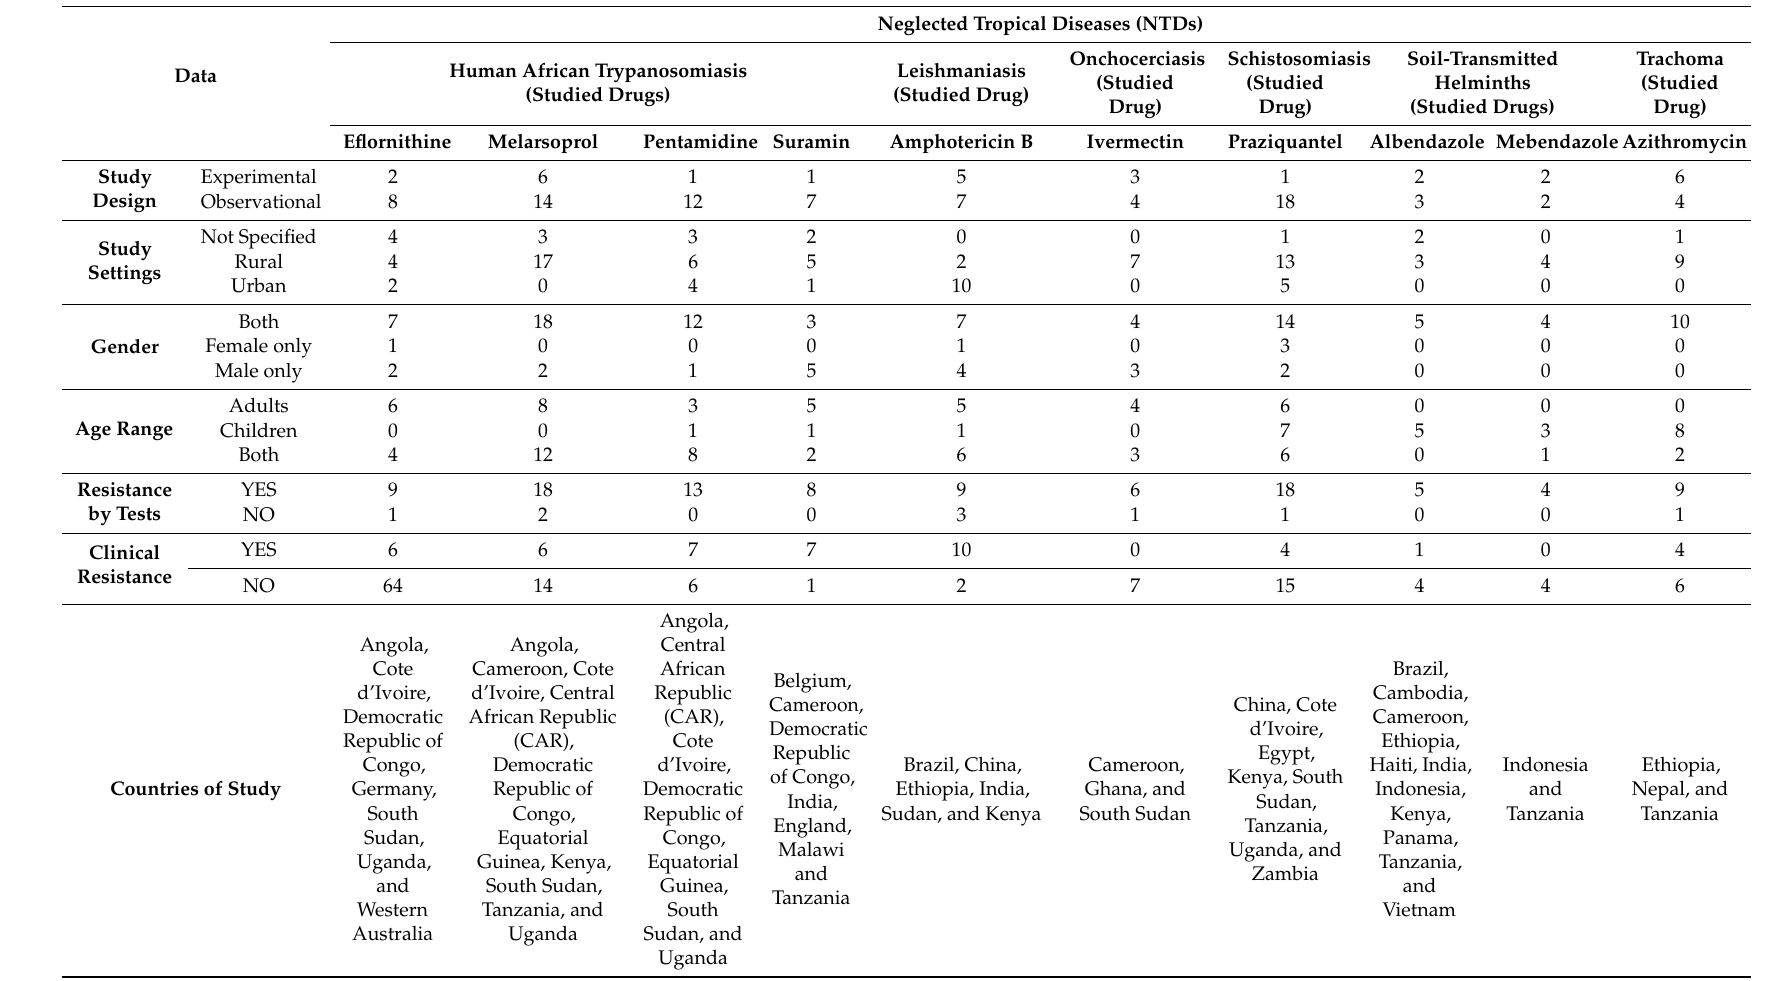
Table 1. The characteristics of reviewed NTDs and their